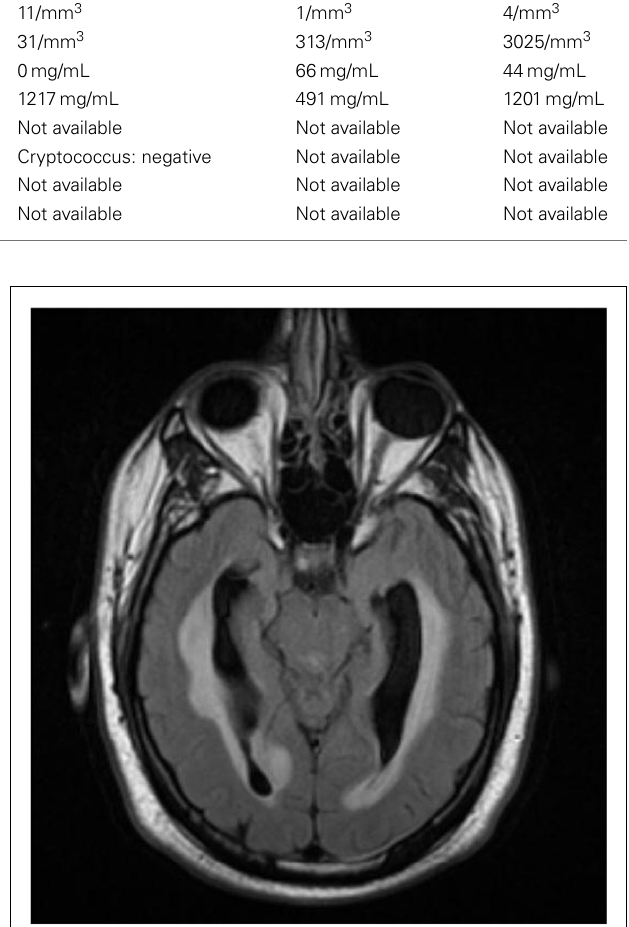
FIGURE 2 |AxialT2 FLAIR image demonstrates mild ventriculomegaly with periventricular signal abnormality consistent with acute